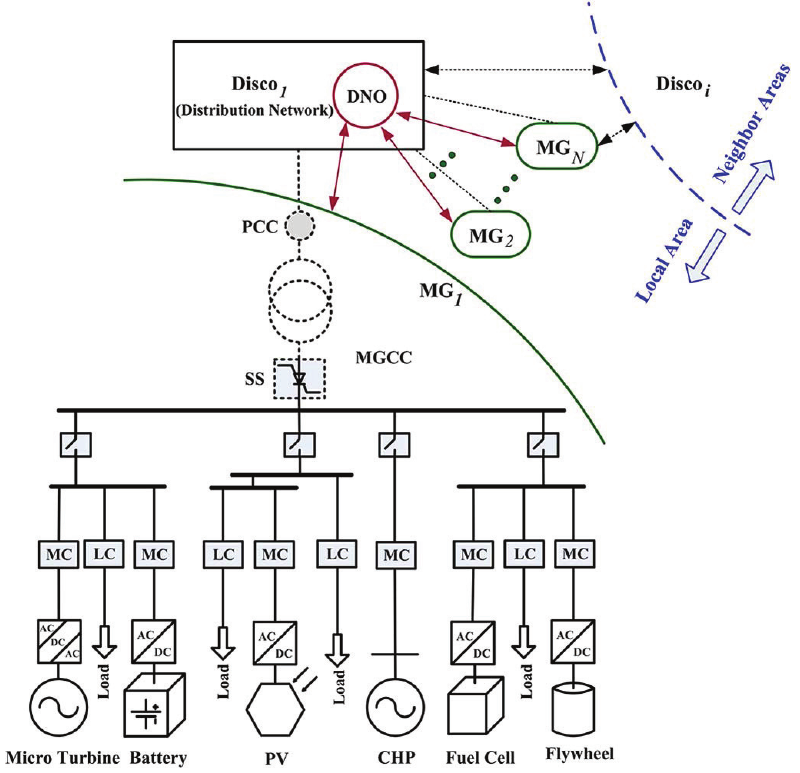
Fig. 1. Local and neighbor areas in a distribution